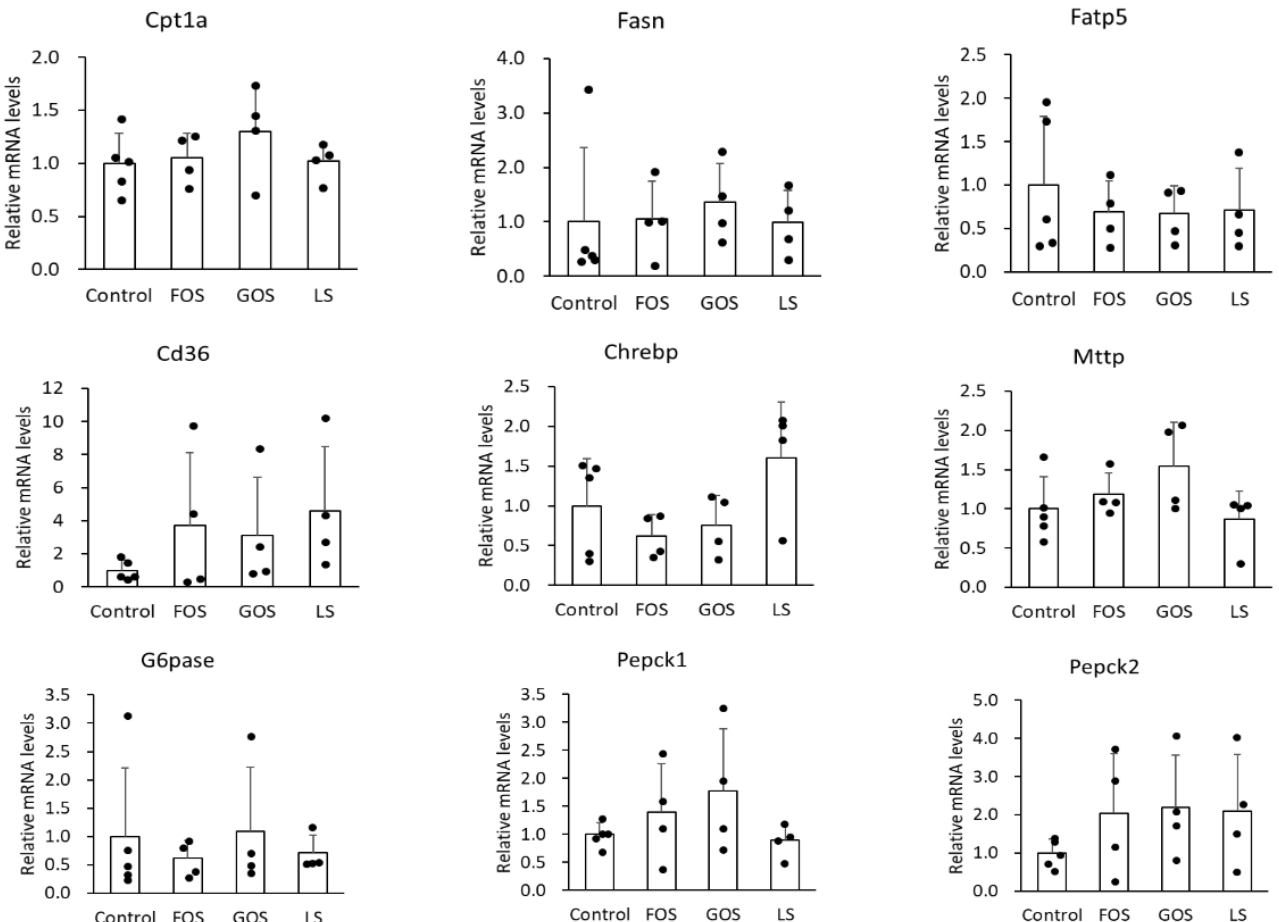
Figure 7. Relative mRNA levels of relate genes involved in lipid metabolism (Cpt1a, Fasn, Fatp5, CD36, Chrebp, and Mttp) and glycogenesis-related (G6pase, Pepck1, and Pepck2) genes in the liver. Values are expressed as means ± SD.